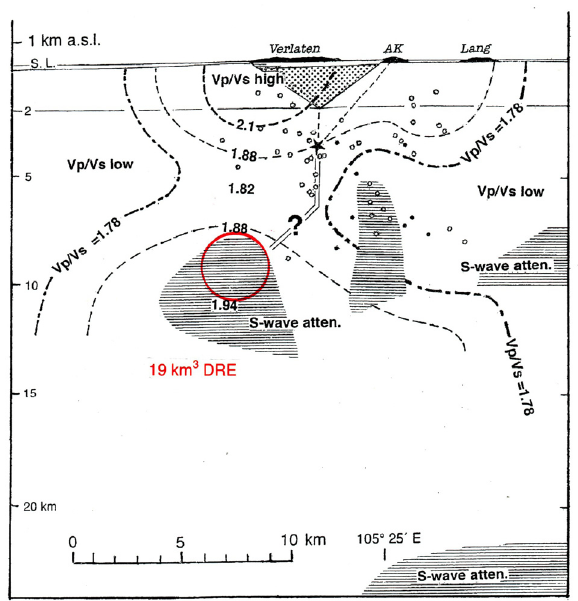
Figure 7. Assumptive caldera deposits and magma reservoir pro- jected on a vertical plane along B—B’ line in Figure 6. Dotted part schematically shows caldera deposits. Distribution of the S-wave at- tenuations (striped parts) was obtained by Harjono et al. [1989] and that of the Vp/Vs ratios by Jaxybulatov et al. [2011]. A colored cir- cle on the assumed magma reservoir shows the total amount of the pyroclastic ejecta (19 km 3 DRE) discharged by the 1883